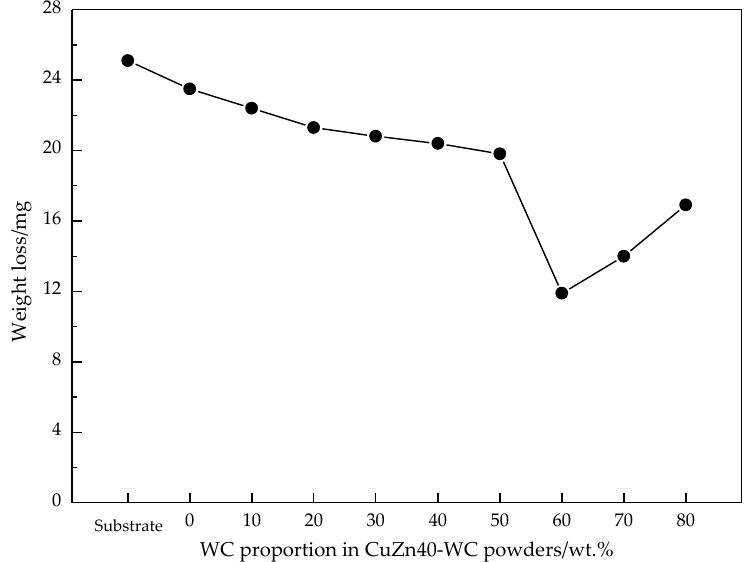
Figure 13. Weight loss of the Al substrate and different cladding layers.